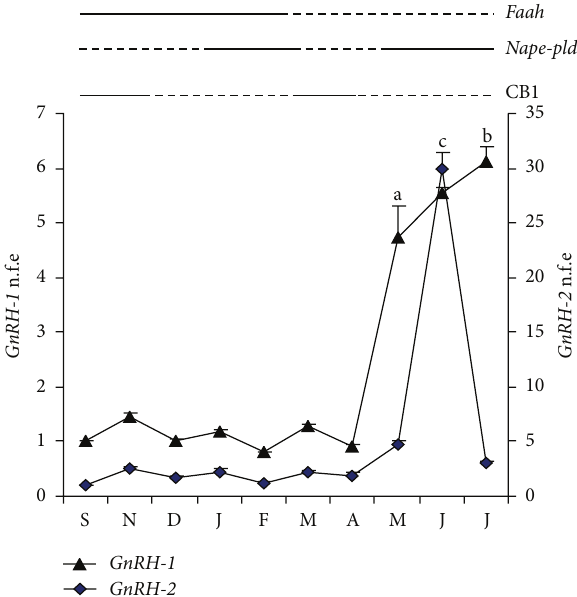
Figure 2: Analysis of GnRH1 , GnRH-2 , and some molecular components of the endocannabinoid system in frog testis during the annual sexual cycle. For GnRH-1 , GnRH-2 , and Nape-pld mRNA data from [6]; for FAAH and CB1 protein data from [7]. Dotted lines: low levels; black lines: high levels. n.f.e.= normalized fold expression. Different letters indicate statistically significant differences.